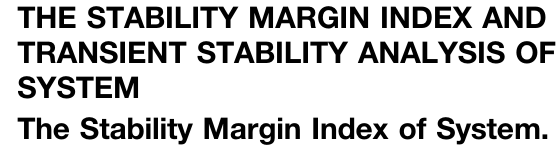
Frontiers in Energy Research |